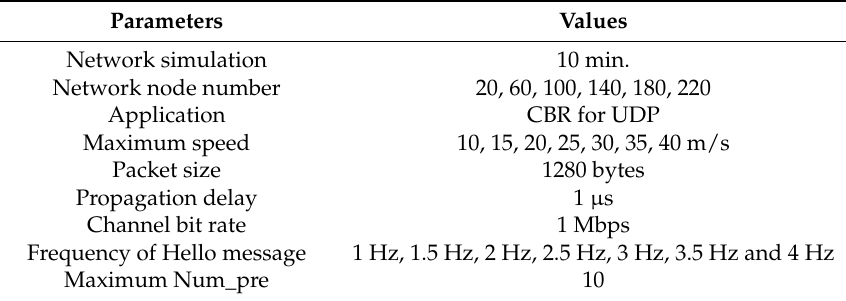
Table 7. Network parameters in